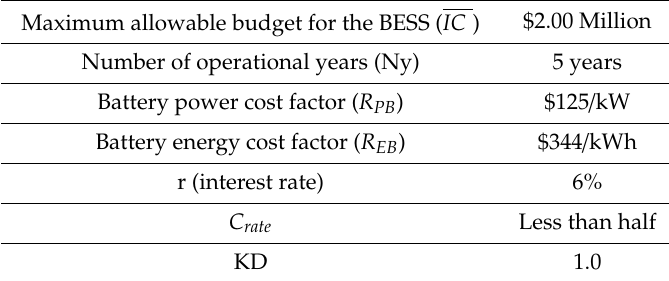
Figure 5. The considered customer one line diagram. Table 1. Assumptions for the base